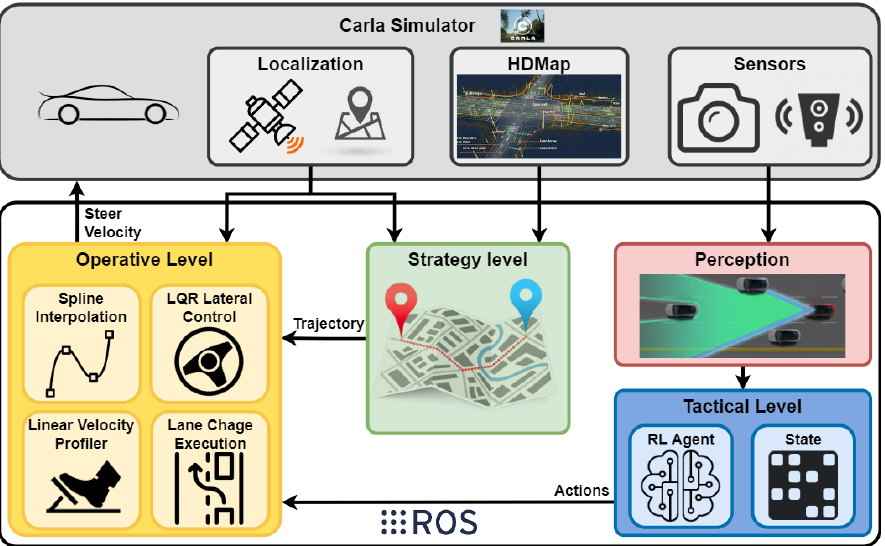
Figure 1. The proposed hybrid architecture. The strategy level defines a trajectory with the map infor- mation and the ego vehicle location. The tactical level executes high-level actions in correlation with the perception information. The operative level combines the trajectory and the actions, calculating the driving